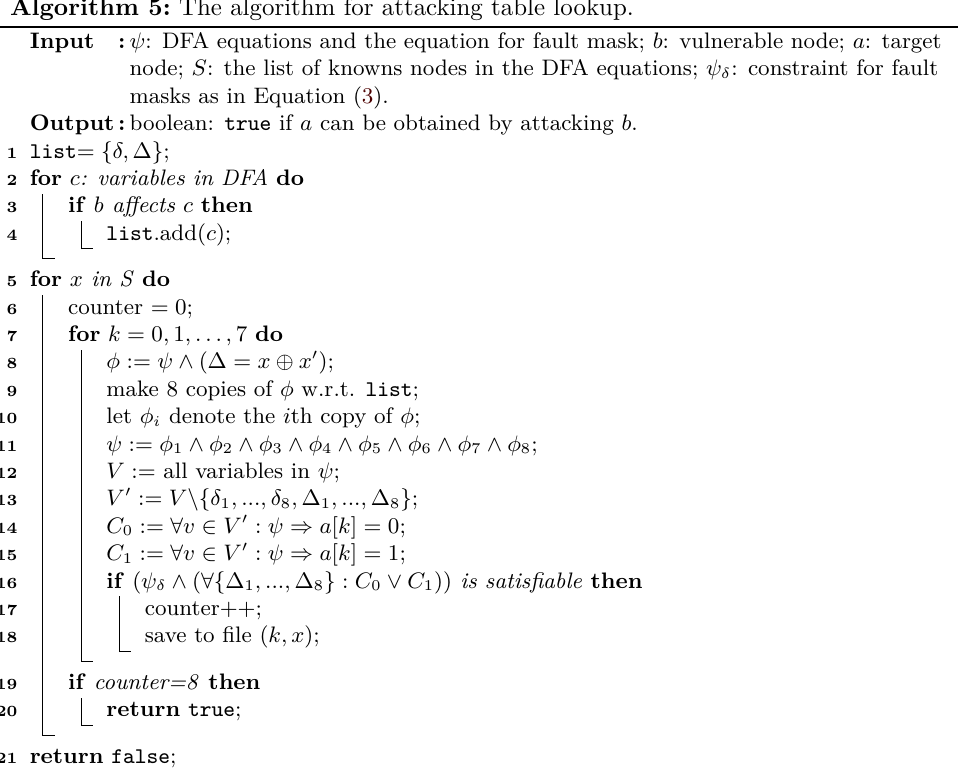
Algorithm 5: The algorithm for attacking table